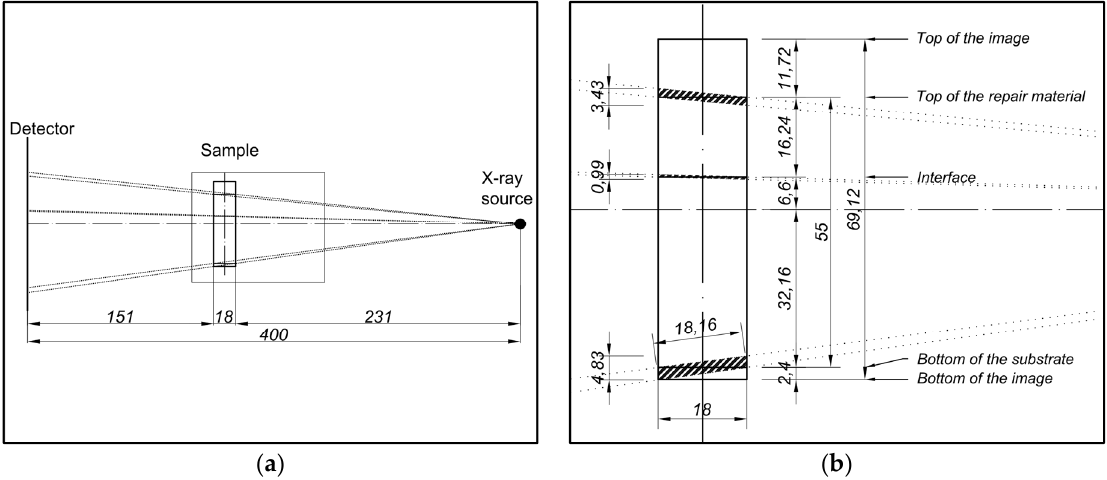
Figure 7. Experimental setup and influence of the conical beam on the measured data, units are in (mm): ( a ) Position of the detector, the specimen and the source; ( b ) Beams passing through the sample, high magnification.